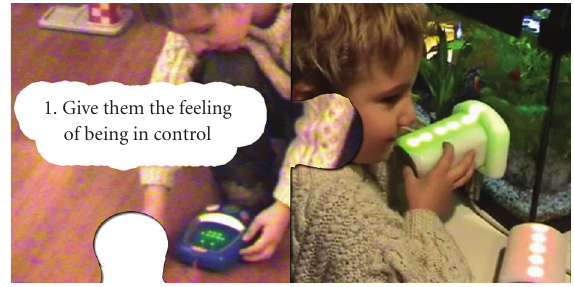
Figure 5: A sense of control. (a) Beer playing with his little number computer: by pushing the button he makes it count from one to ten. (b) Beer playing with LINKX: by linking a block to the speech- o-gram he makes it say the word